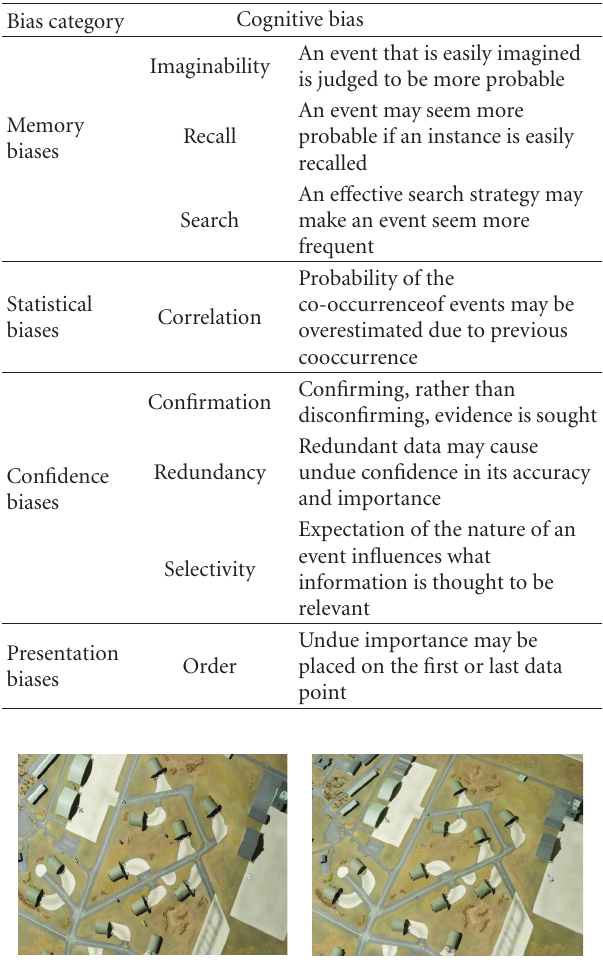
Table 1: Potential biases in object identification.